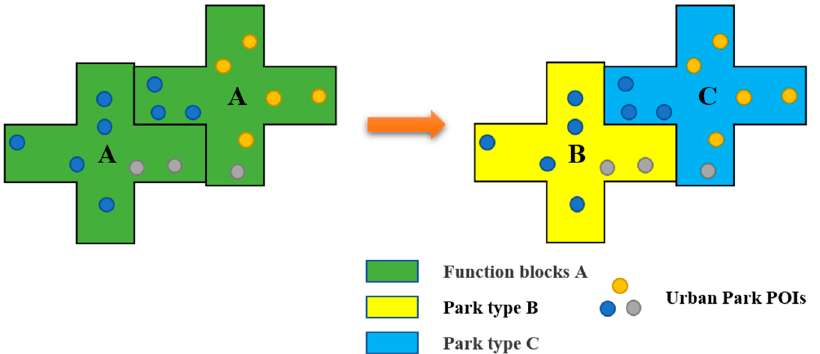
Figure 11. POI attribute mapping methods.